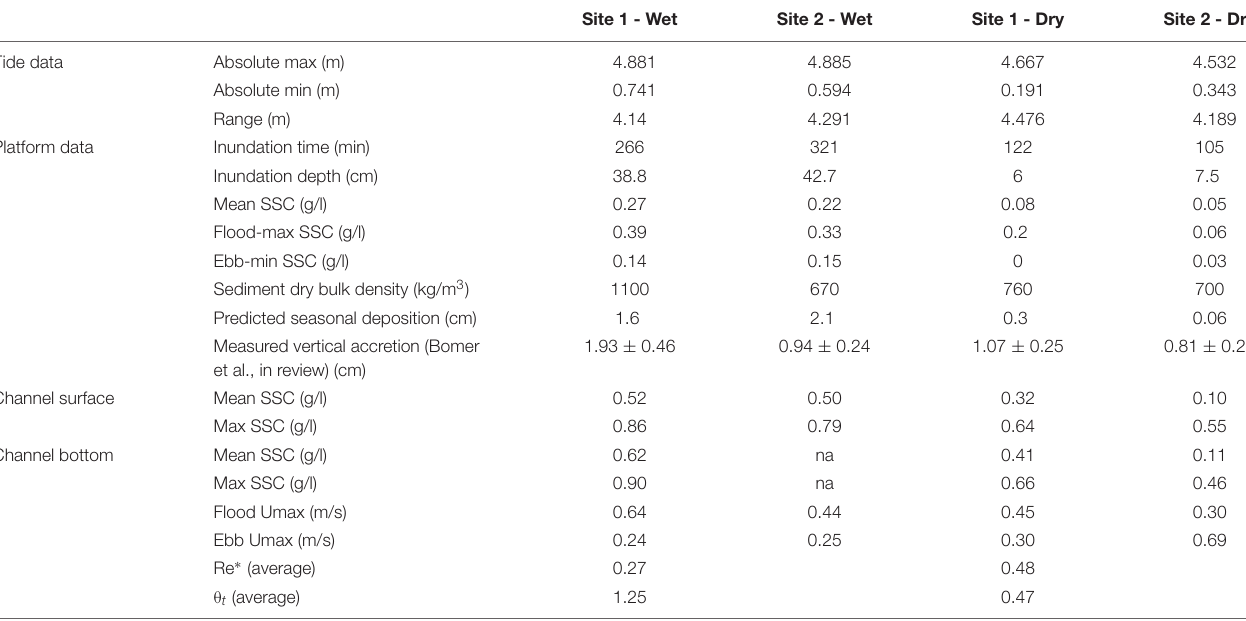
TABLE 1 | Values of water level, SSC, and velocity measured during the single-day